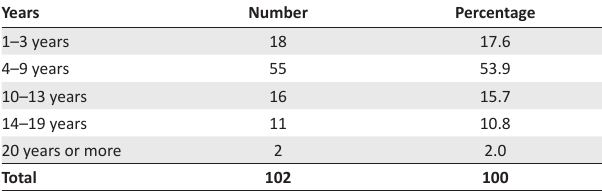
TABLE 4: Respondents’ number of years in